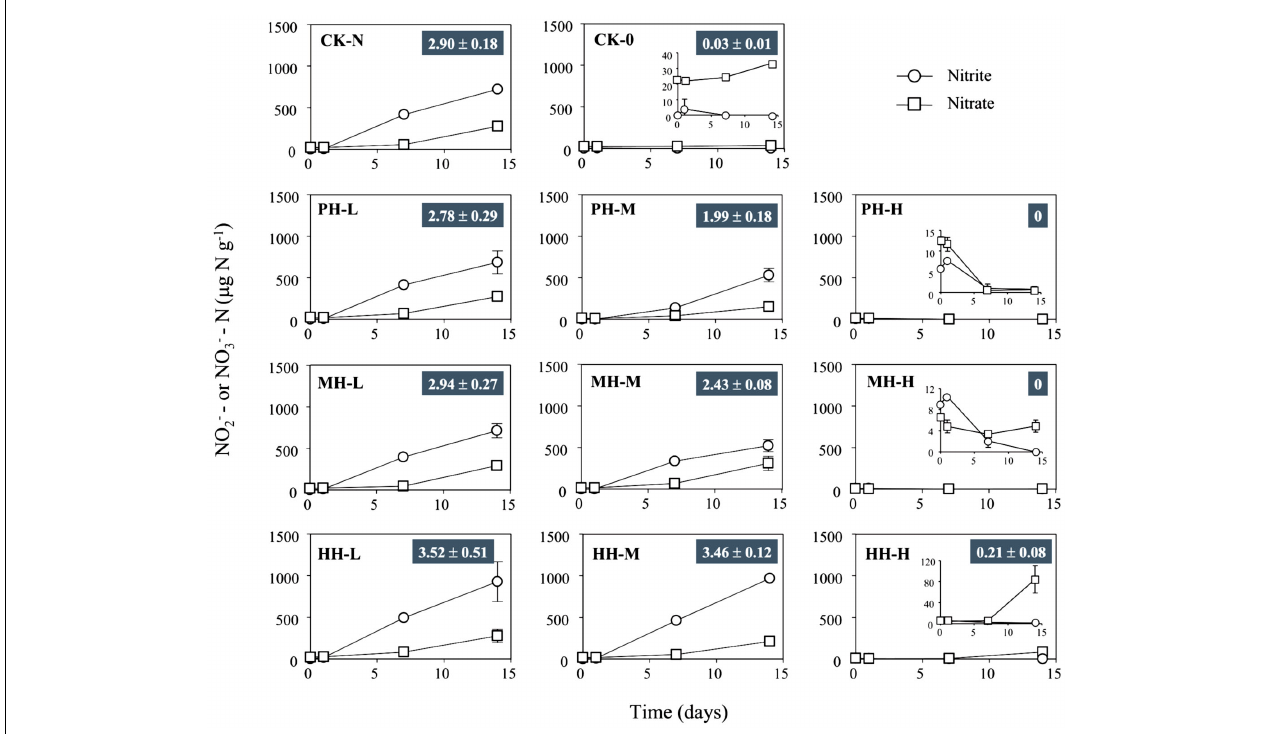
− N and NO − − N in soil microcosms FIGURE 1 | Concentration of NO − soil), and high (100 μ molg − 1 soil) concentration, respectively. Each point 2 3 incubated for 14days at various concentrations of phenylhydrazine represents the mean of triplicate microcosms with some error bars smaller hydrochloride (PH), methylhydrazine sulfate (MH), and than the symbol size.The inserts show the same data on a smaller scale.The 2-hydroxyethylhydrazine (HH). The designations of PH-L, PH-M, and PH-H values in gray box refer to nitrification rate during the 14day incubation − Ng − 1 represent PH in the microcosms at low (1 μ molg − 1 soil), medium (10 μ molg − 1 (mean ± SE, μ gNO − x